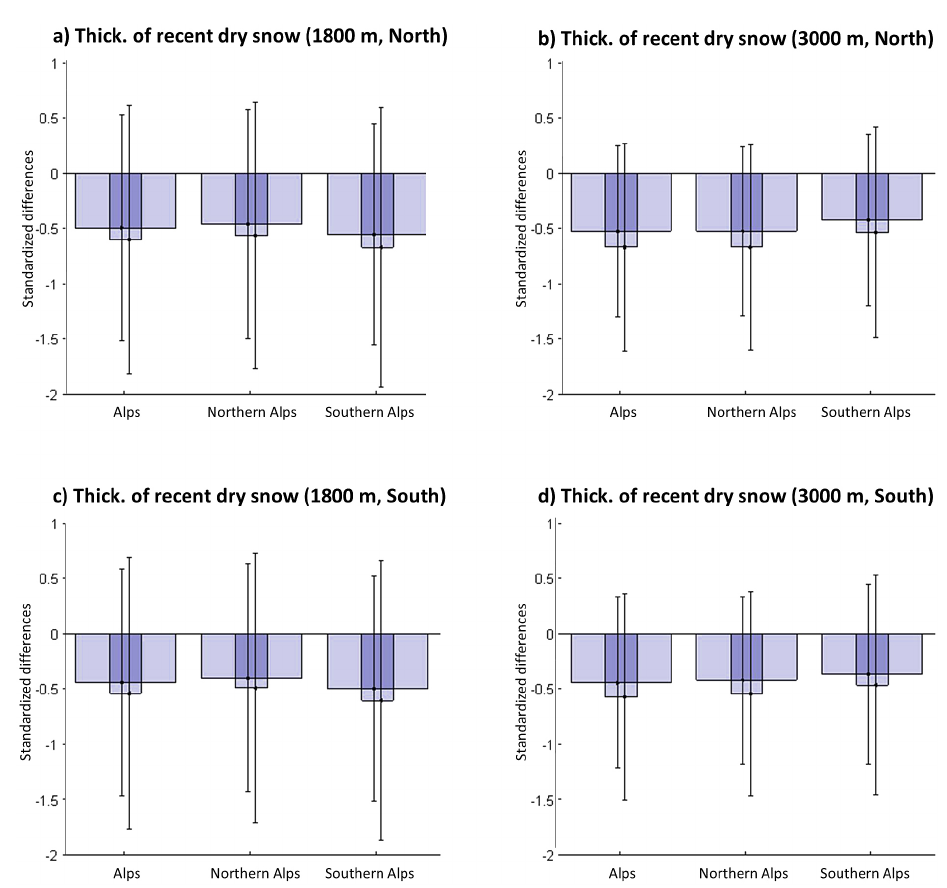
Figure 8. Same as for Fig. 4 but with regard to thickness of recent surface dry snow (north and south facing slope, at 1800 and